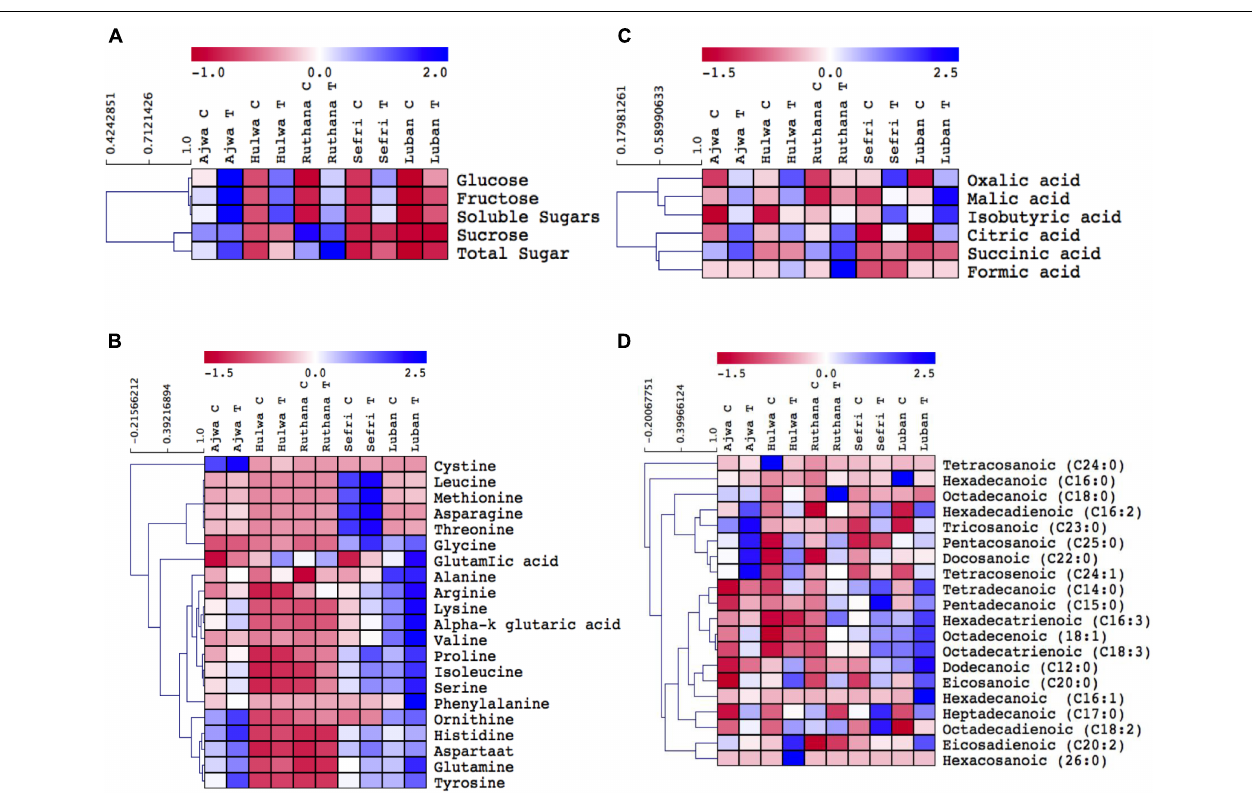
FIGURE 1 | Hierarchical clustering of primary metabolites [sugars (A) , amino acids (B) , organic acids (C) , and fatty acids (D) ] concentrations in vermicompost-fertilized and non-fertilized P. dactylifera cv. Ajwa, Hulwa, Ruthana, Sefri, and Luban fruits. Vermicompost fertilization was carried out at a rate of 10 Kg/tree and fruits were harvested at the tamar